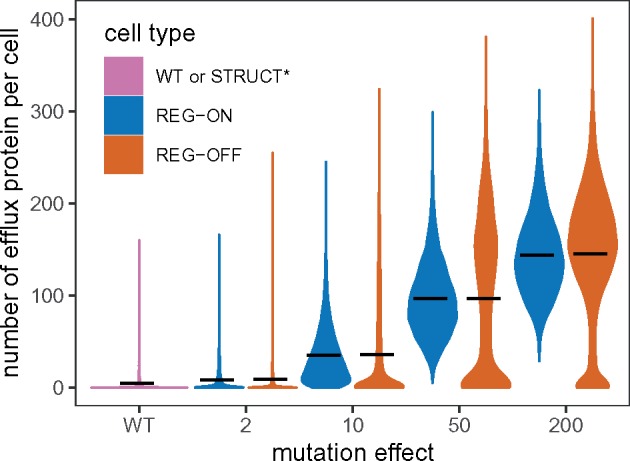
The distribution of efflux protein copy number per cell for regulatory mutants, across a range of mutant effects μ. Wild-type (WT) cells are included for comparison, and the expression of structural mutants is identical to WT. The mean protein copy numbers per cell are indicated by solid black lines. A population of 10,000 individual cells was simulated up to t = 1,200 min in the absence of drug, tracking only a single cell following each division event. Numbers are recorded immediately after cell division.